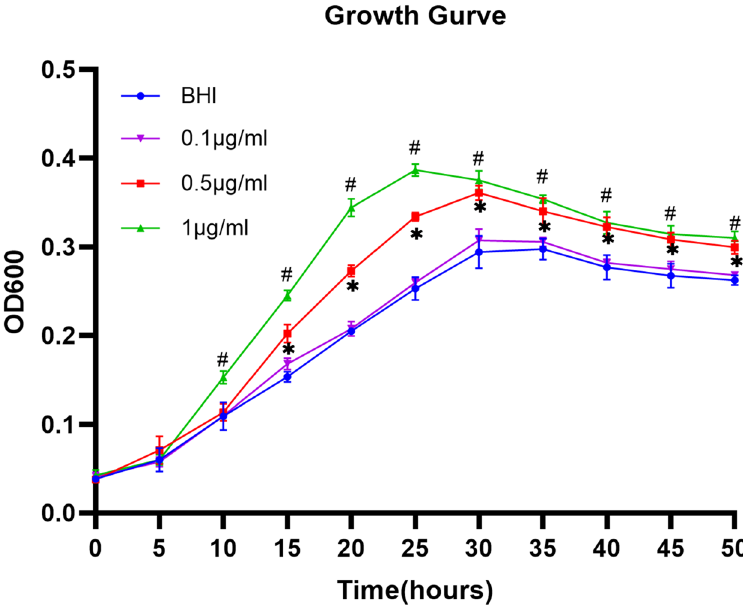
Figure 6. Growth curves of Akkermansia muciniphila under different conditions. Data are presented as the mean ± S.E.M. * P < 0.05, BHI compared with TFA (0.5 µg/mL), # P < 0.05, BHI versus TFA (1